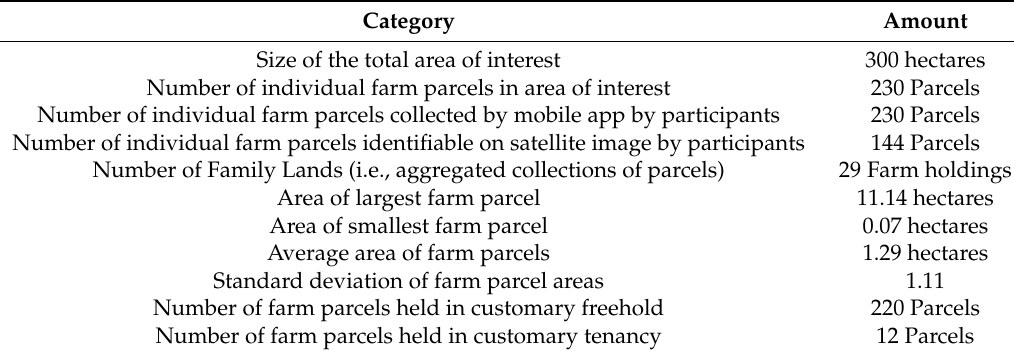
Table 2. Summary of Data